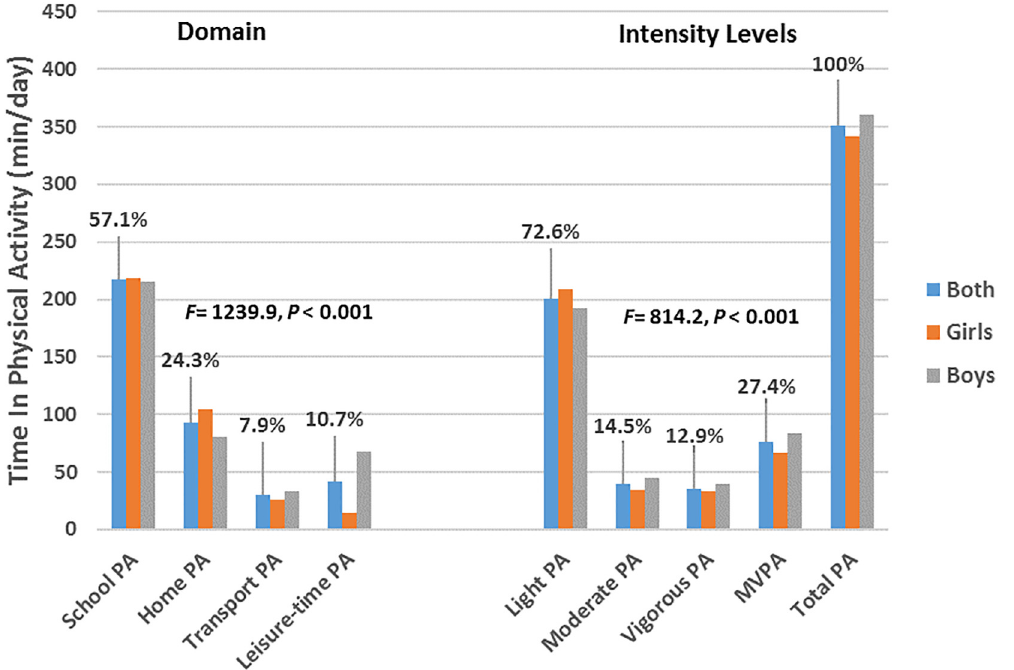
Fig 1. Proportion of time in domain and intensity levels of physical